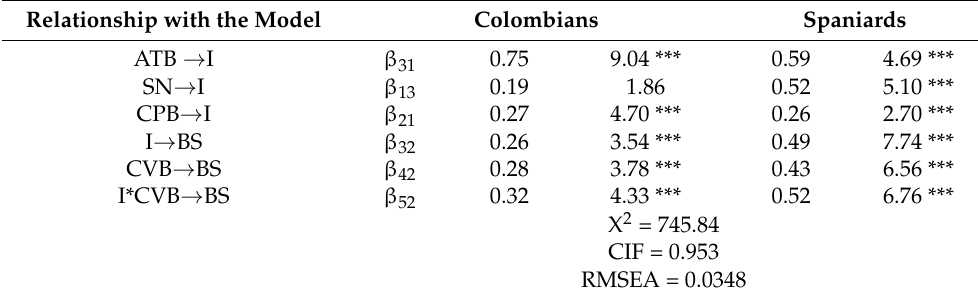
Table 3. Structural